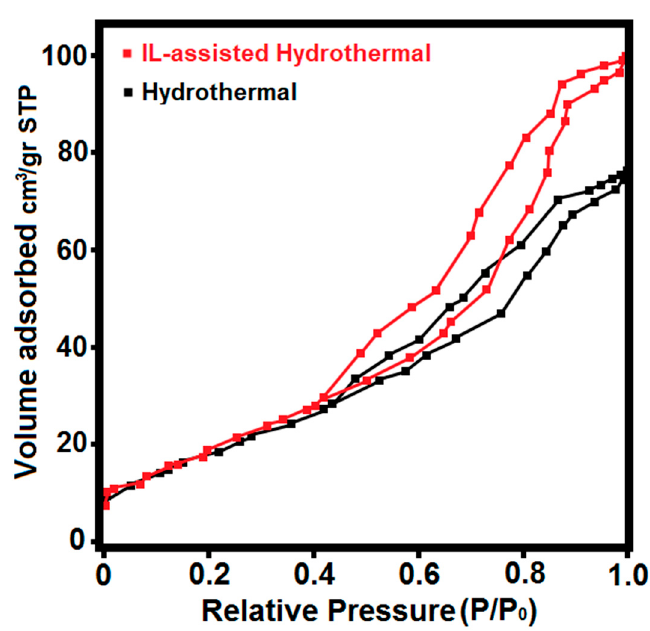
Figure 4. Nitrogen adsorption-desorption isotherm of the obtained products.